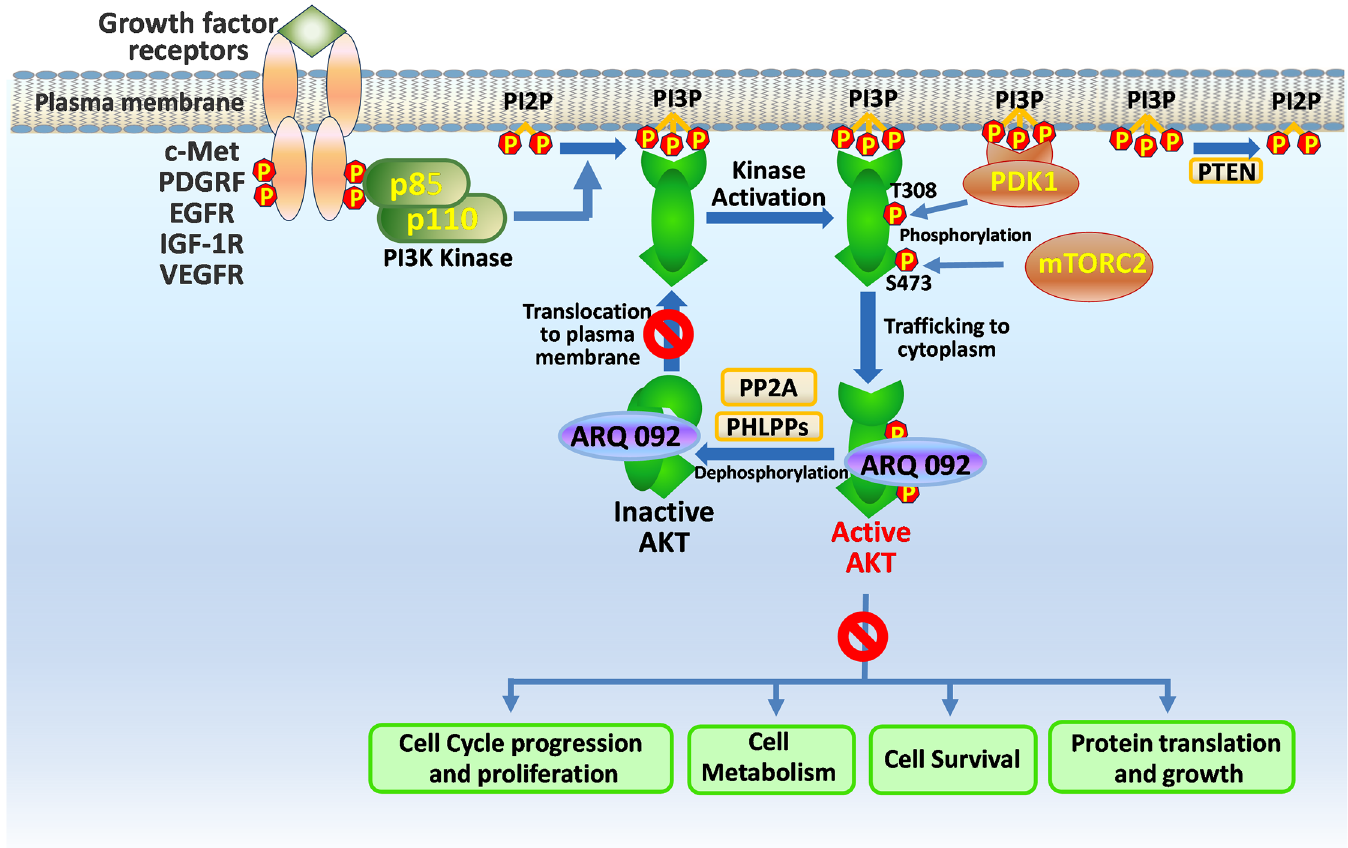
Fig 9. Proposed AKT pathway inhibition by ARQ 092 (and ARQ